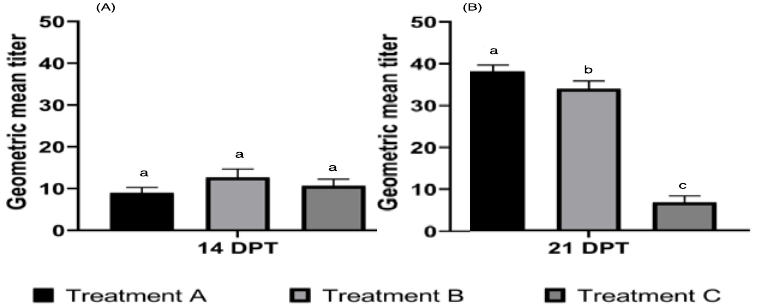
Figure 2. Inhibition of hemagglutination assay (HI) from serum of treatments A, B, and C. Systemic immune response of treatment A (virus-inactivated antigen), treatment B (HAr), and treatment C (PBS/A1) via ocular application at 14 and 21 days post-treatment (DPT) were evaluated by the HI assay expressed in geometric mean titer (GMT). ( A ). Treatment A (GMT = 8.97 ± 1.30), treatment B (GMT = 12.70 ± 1.98), and treatment C (GMT = 10.67 ± 1.59) indicated that no statistical difference was observed ( p > 0.05) at 14 DPT. ( B ) . Immune response at 21 DPT was observed in treatment A (GMT = 38.05 ± 1.54), treatment B (GMT = 33.90 ± 1.86) and treatment C (GMT = 6.72 ± 1.54) with a statistical difference ( p > 0.05) in comparison to each other. Literals indicate a statistical difference ( p -value < 0.05).